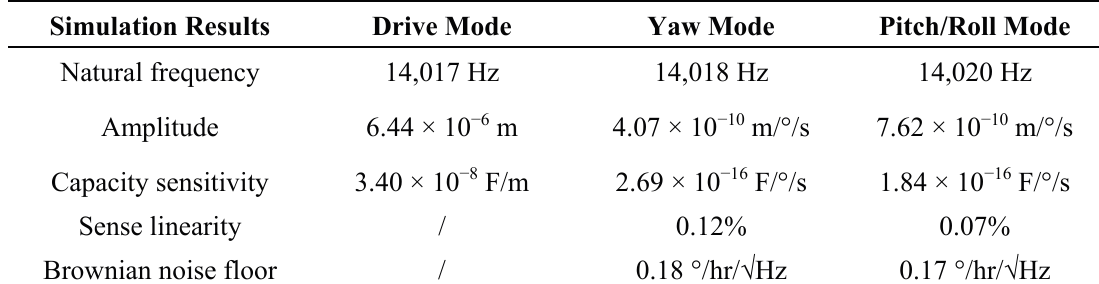
Table 7. Simulation